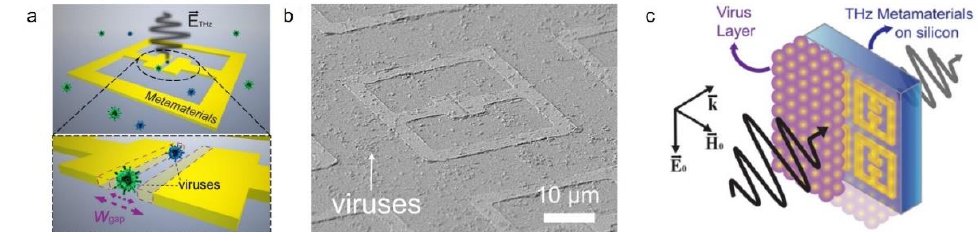
Figure 2. ( a ) Schematic illustration of nano-gap metamaterial structure for THz sensing of viruses. ( b ) SEM image of the viruses deposited on the structure with a gap width (w) of 200 nm. ( c ) Schematic depiction of the measurement of the dielectric constant of virus layers using the THz metamaterial structure [59] © 2017 Optical Society of America.